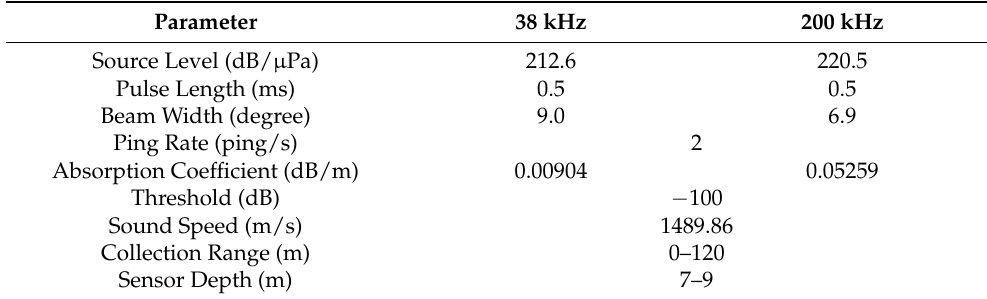
Table 2. System parameters of the scientific echosounder used for acoustic surveys in the Yellow Sea Bottom Cold